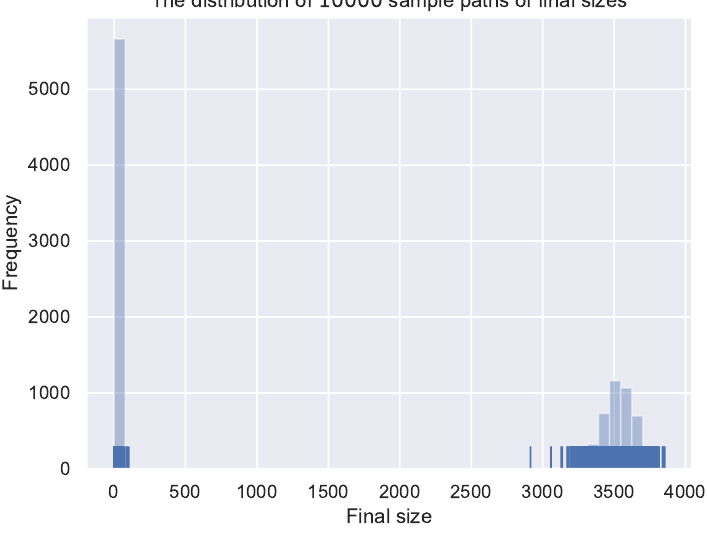
Figure 7. The distribution of the final sizes of 10 4 realizations for the CTMC model (3) with two exposed stages (simulated with